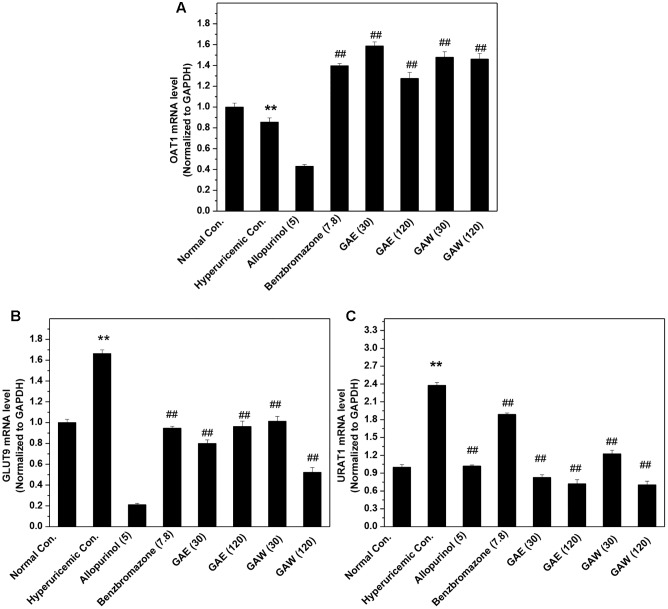
Effects of GAE and GAW for renal (A) OAT1, (B) GLUT9, and (C) URAT1 mRNA. ∗∗P < 0.01 compared to the normal control; ##P < 0.01 as compared to the hyperuricemia control.